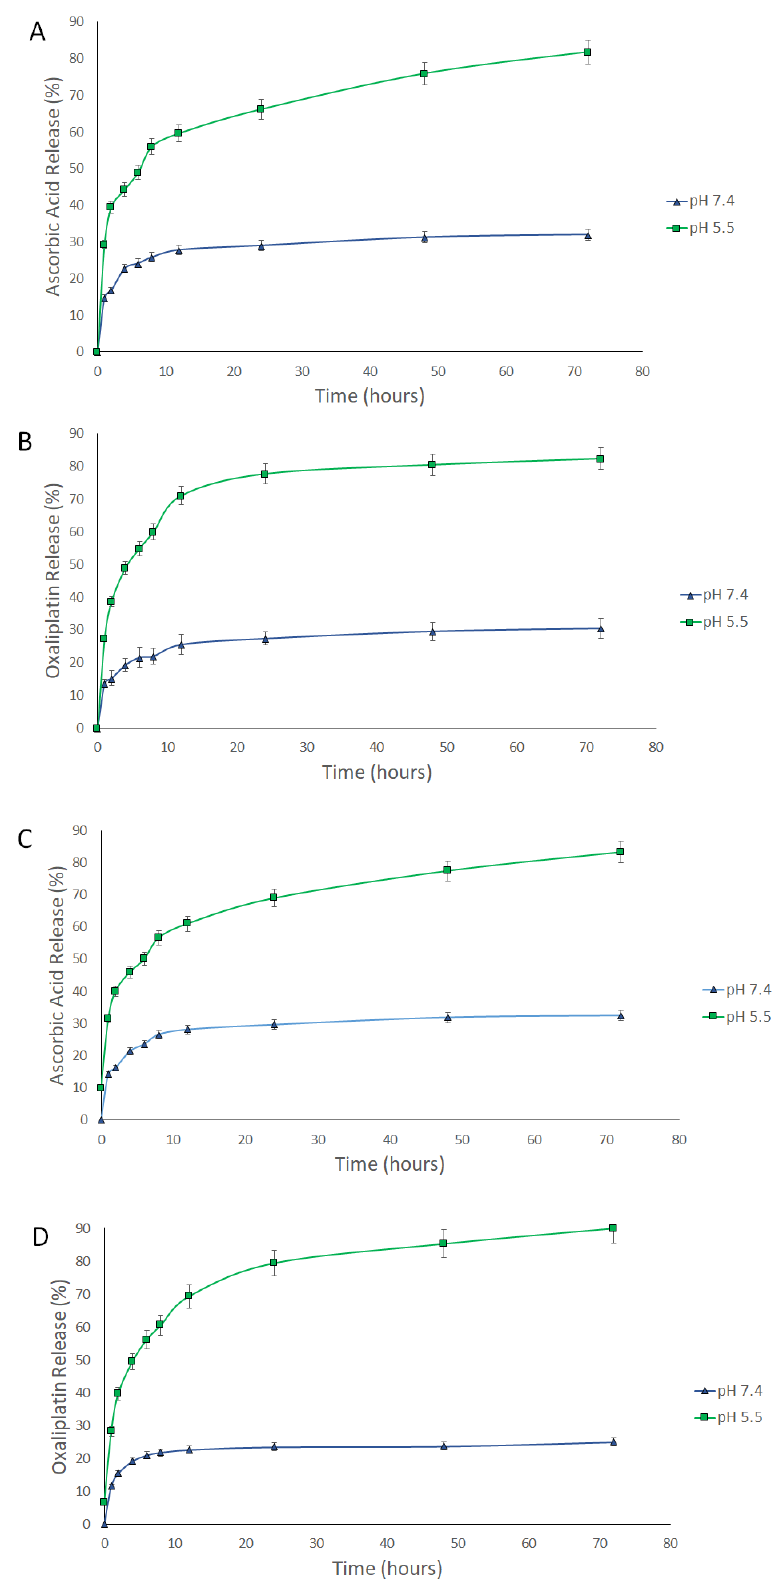
Figure 4. Time-dependent release profiles of ( A ) AA from AA/PEG-CS NPs, ( B ) OX from OX/PEG- CS NPs, ( C ) AA from AA-OX/PEG-CS NPs, and ( D ) OX from AA-OX/PEG-CS NPs at 37 °C, at pH 7.4 and 5.5.